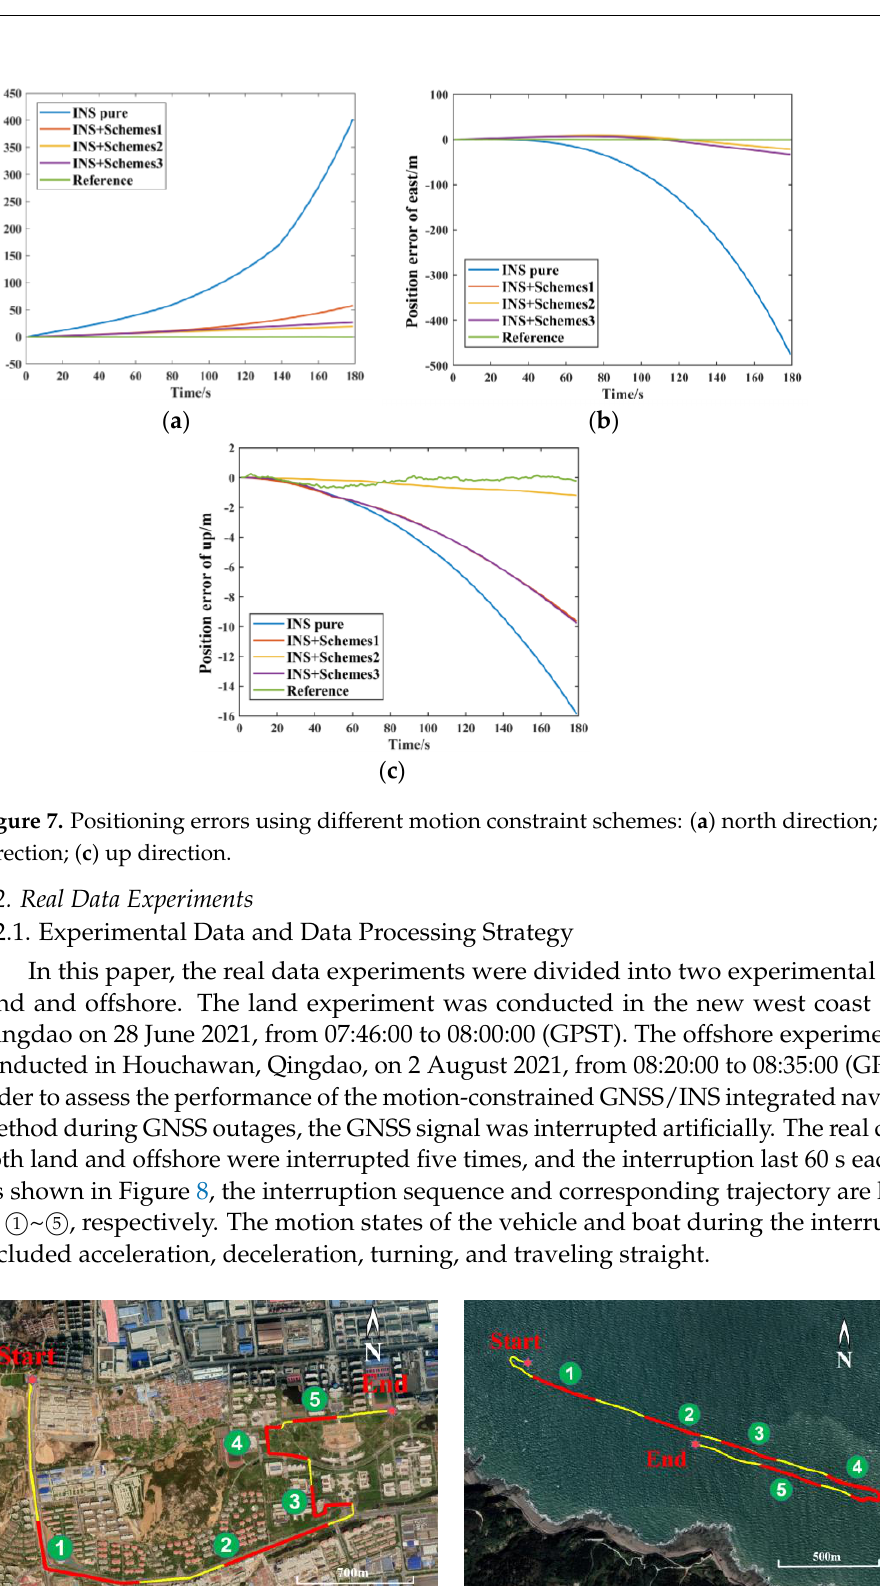
( b ) Figure 9. Experimental instrument and carriers: ( a ) vehicle; ( b ) boat. Table 2. Navigation and positioning sensor parameters. Sensor Type